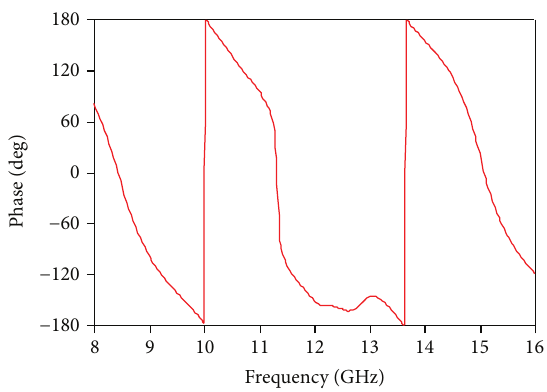
Figure 15: Phase value of the proposed